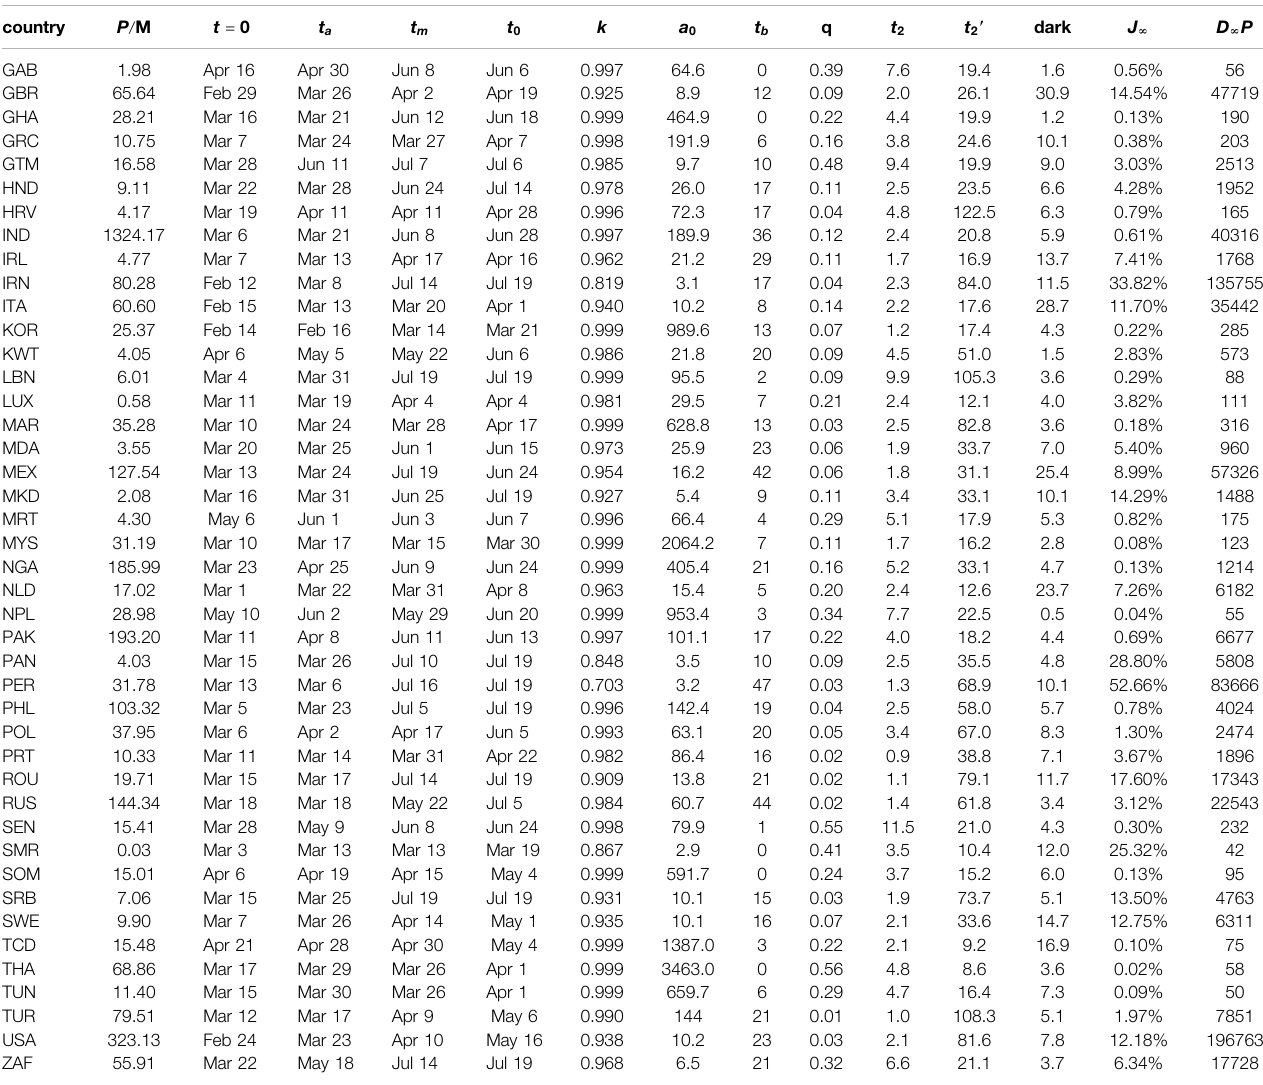
TABLE 3 | Continuation of Table 2 .